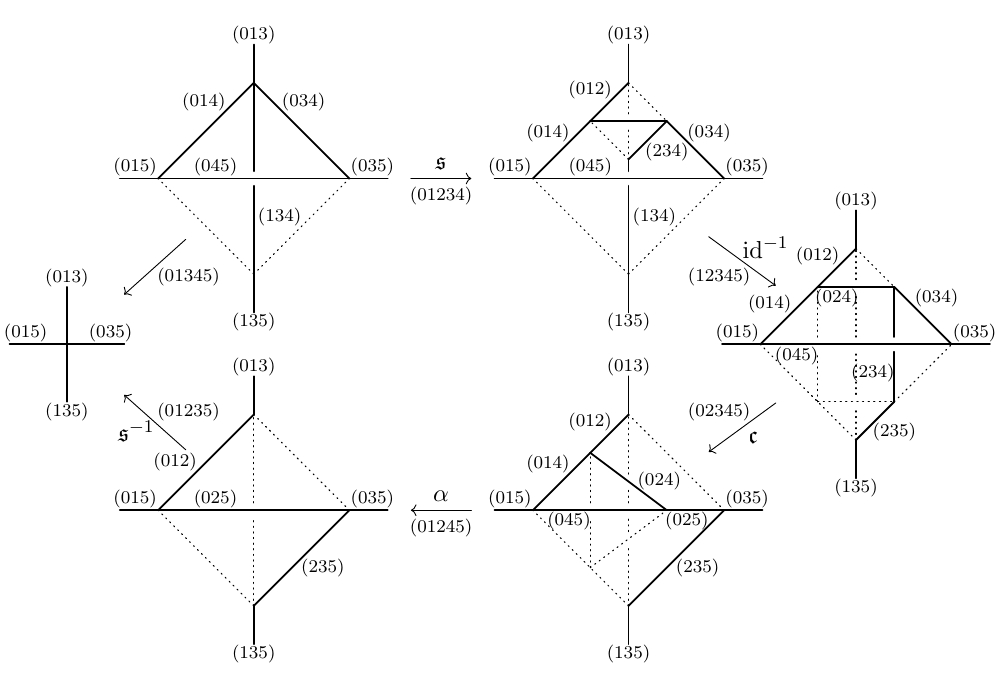
Figure 3 . Graphical depiction of the 2-form cocycle condition d (4) ! ( a; 0 ; c; d j 0 ; 0 ; 0 j h; 0 j 0)